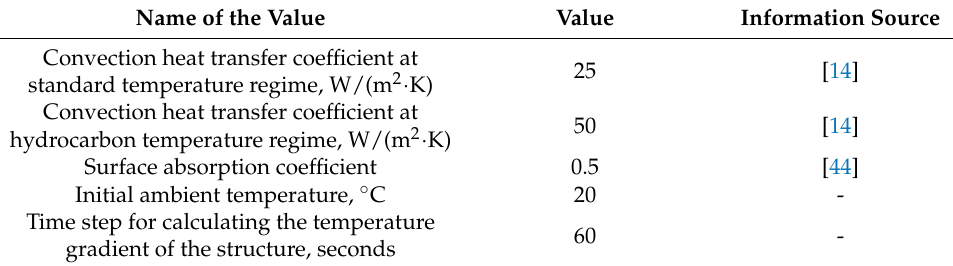
Table 2. Boundary conditions set in the SP